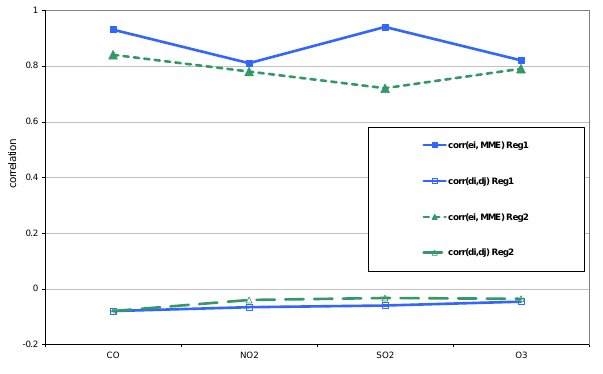
Fig. 1. Correlation of errors (between individual model and MME and between d for all model pairs) for region 1 and region 2 of Europe for the months of JJA of 2006.